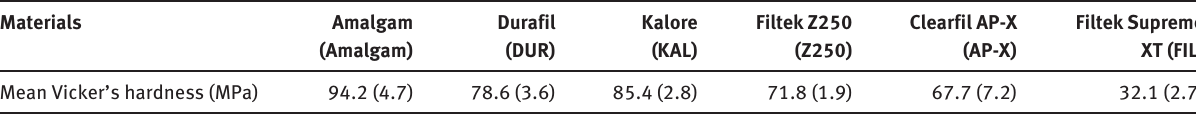
Table 2: Vicker’s hardness values of restorative composite materials before chewing tests. Materials